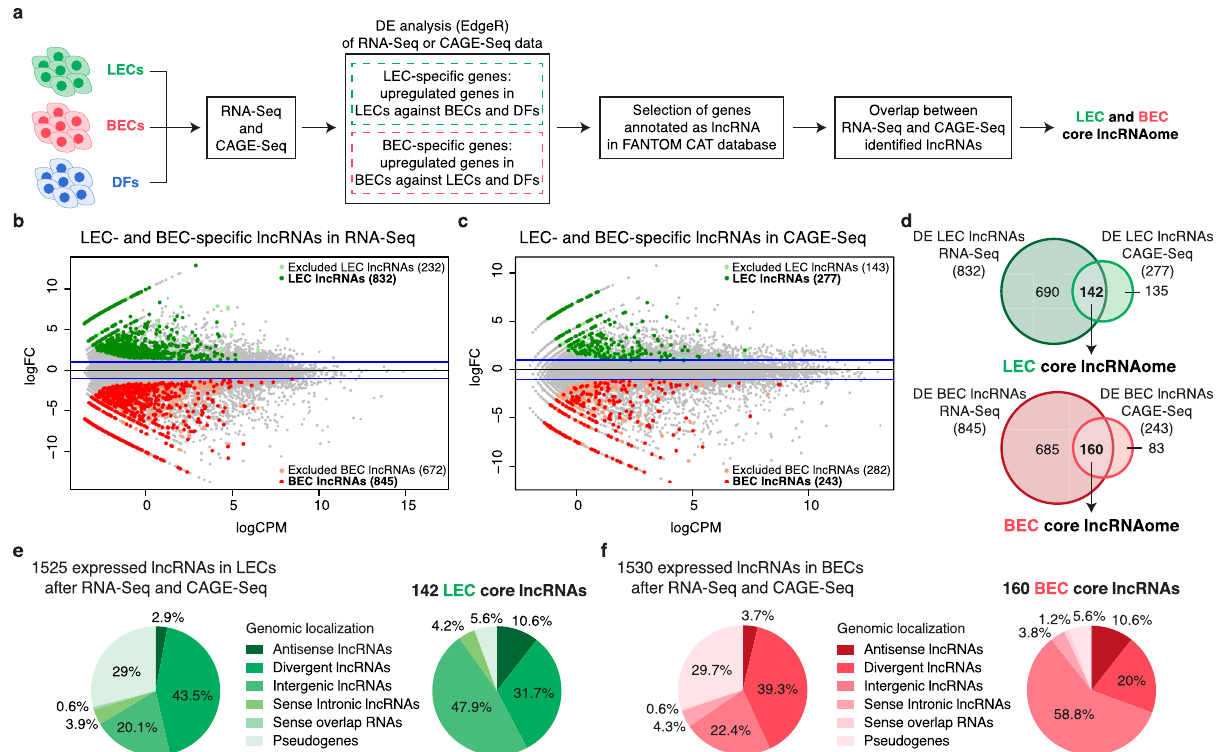
Fig. 1 Identi fi cation of a core subset of vascular lineage-speci fi c lncRNAs. a Schematic representation of the analysis pipeline. Total RNA was extracted from two replicates of neonatal lymphatic and blood vascular endothelial cells (LECs and BECs) derived from the same donor and subjected to both RNA- Seq and Cap Analysis of Gene Expression (CAGE-Seq). Neonatal dermal fi broblasts (DFs) data from FANTOM6 database 33 were included to increase endothelial cell speci fi city. After differential expression (DE) analysis using EdgeR 34 , we overlapped the results from RNA-Seq and CAGE-Seq data to select lncRNAs differentially expressed in both techniques. b , c MA plots displaying log 2 fold change (log 2 FC) against expression levels (logCPM) of DE genes after RNA-Seq b and CAGE-Seq c between LECs and BECs. Green and red dots: LEC- and BEC-speci fi c lncRNAs (FDR < 0.01); light green and light red dots: lncRNAs excluded from the analysis because also expressed in DFs; blue horizontal lines: chosen |log2FC|> 1 cutoff. d Venn diagrams showing the overlap between RNA-Seq and CAGE-Seq and the identi fi ed LEC- (top) and BEC (bottom) core lncRNAs. LEC and BEC core lncRNAs are listed in Supplementary Data 2. e , f Pie charts showing the genomic classi fi cation according to FANTOM CAT database 13 of LEC e and BEC f core lncRNAs compared to lncRNAs generally expressed in LECs or BECs by both RNA-Seq and CAGE-Seq (RNA-Seq: TPM > 0.5 and CAGE-Seq: CPM >